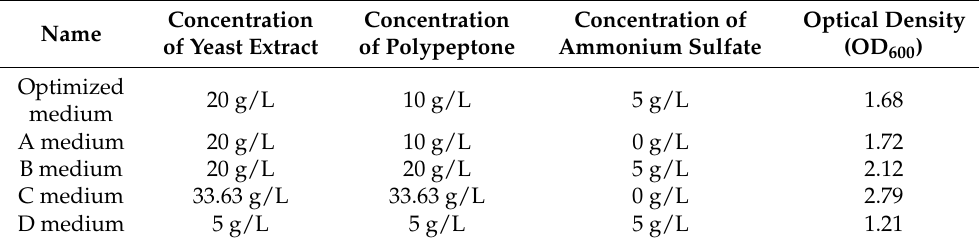
Table 2. Media and OD 600 used for the bio-cementation of coarse